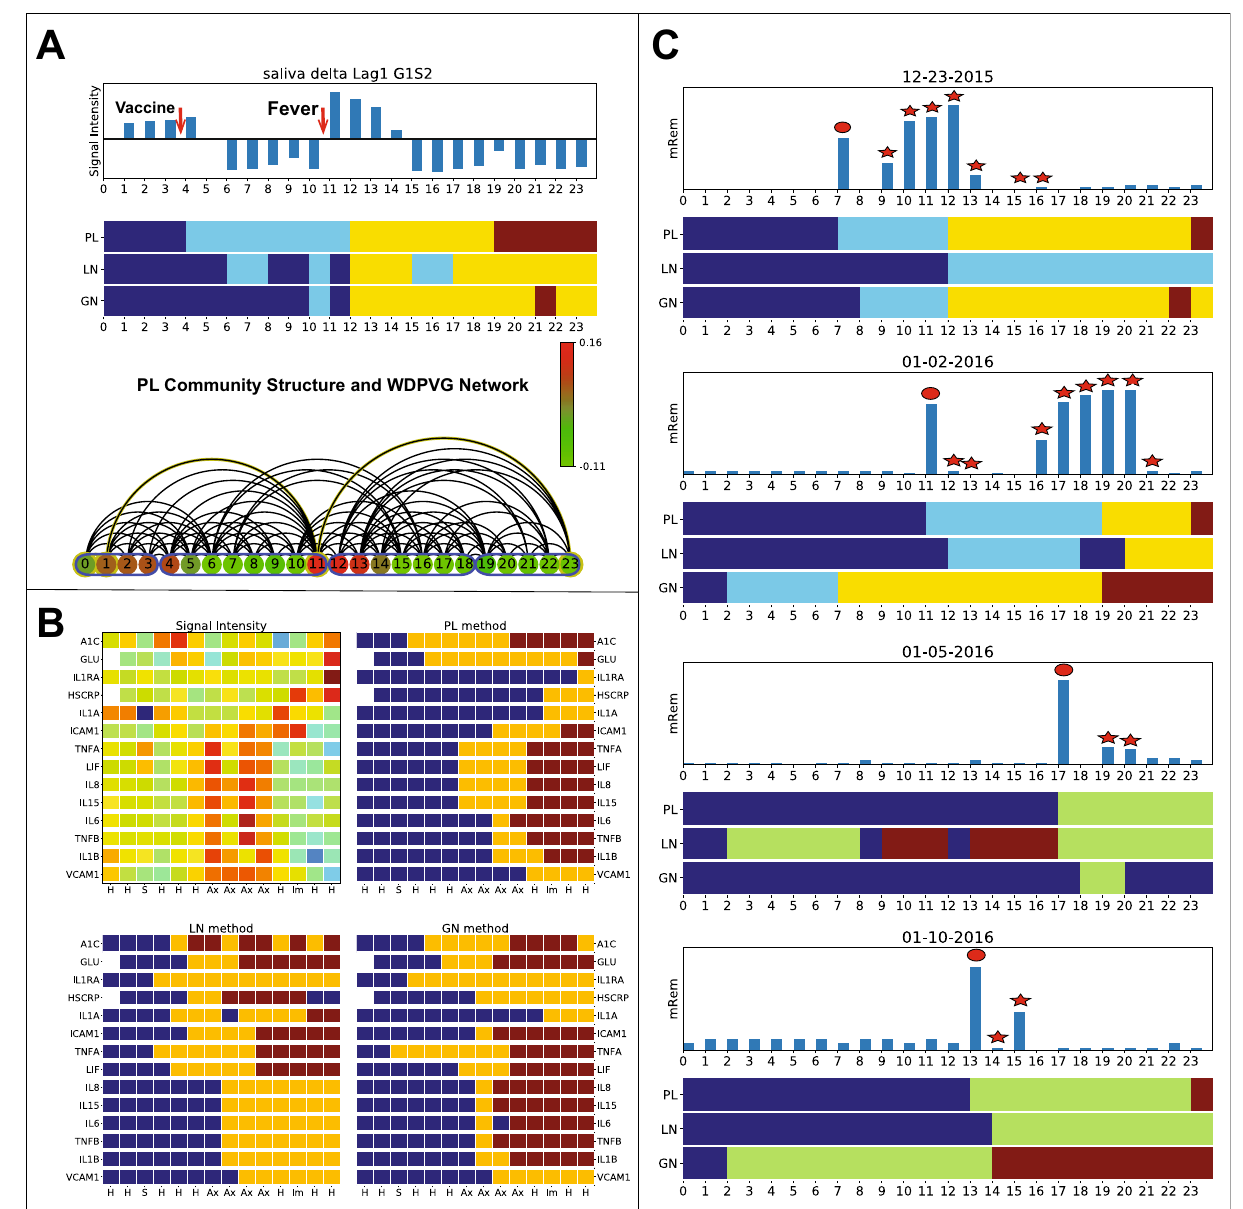
Figure 5. Results of our visibility graph based community detection method applied to experimental biological datasets. ( A ) Shows the results of applying different methods to an individual’s saliva omics time series before and after their vaccination, over a 24 h period. The time series indicates average gene expression for a subset of genes with autocorrelated behavior. The VG nodes’ color in ( A ) bottom represents the intensities of the time series, and nodes belonging to the same detected community are framed by a blue border. The communities correspond well to the four physiological subject states of biological significance: prior to vaccination, after vaccination, a post vaccination fever period and resolution, post fever relative recovery. ( B ) The standardized intensities of A1C, fasting glucose and selected immune cytokines time series from a subject with Type 2 diabetes ( B top left) and the community structures computed individually for each signal are shown for different methods. The data are ordered temporally from left to right, and physiological states are indicated per timepoint as one of H (healthy), S (stress), Ax (antibiotic regiment) and Im (immunization) states. For the experimental data, warm colors indicate higher and colder colors lower intensities respectively. In the methods’ results, nodes belonging to the same community are depicted with the same color bar. The communities structure reflects the changes in physiological state that result from molecular intensity differences. ( C ) The radiation intensity data from wearable biosensors in four separate days including flight activity are shown. The red disc indicates that the radiation was recorded during the airport carry-on luggage check. Stars represent radiation monitored during flight timepoints. Again, nodes in the same community are indicated with the same color in the horizontal bars. The PL community structures during each of these four days indicate the periods of varying radiation exposure, and correctly identify the onset of the